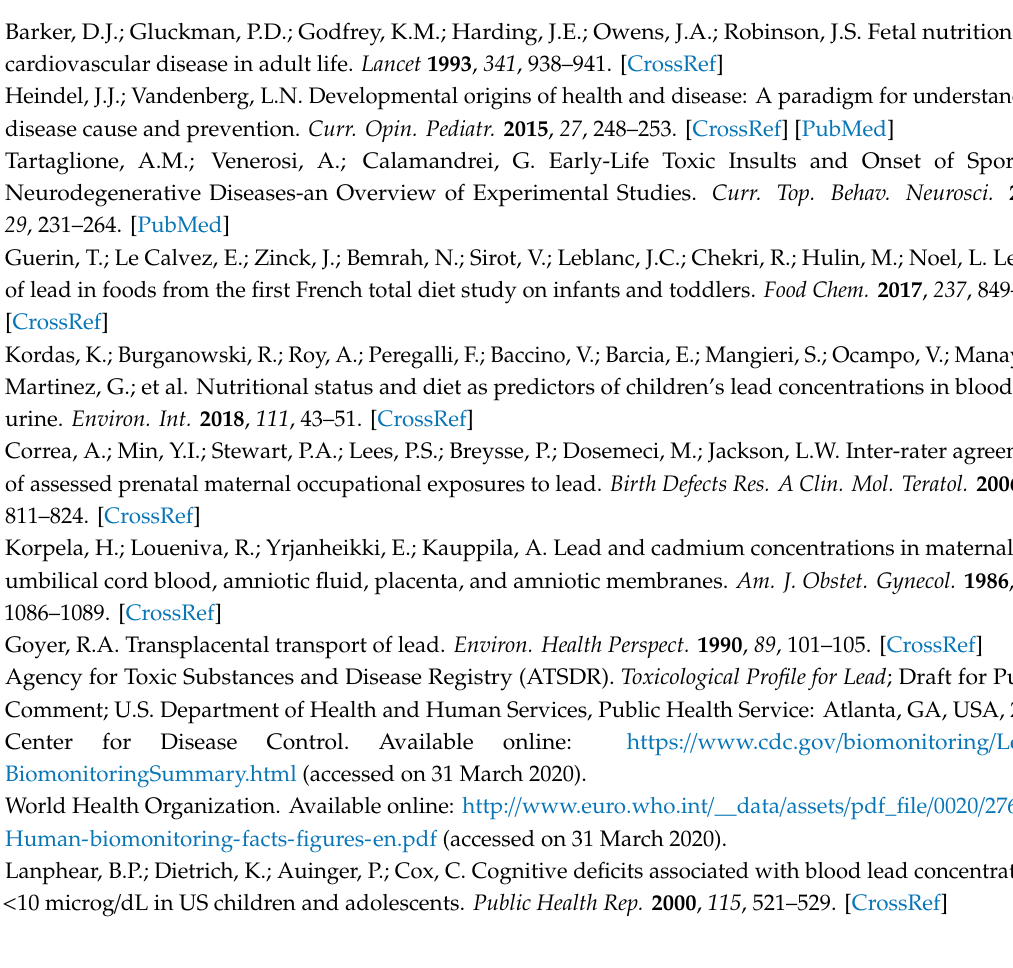
Table S2. E ff ect of Developmental Pb Exposure on the Expression of NMDA and AMPA Receptor Subunits in the Total Homogenate of 23 Post-Natal Day Female (A) and Male (B) Rat Hippocampi. Data were normalized on actin levels. Values are represented as % of Veh (mean ± SEM and n); ns—not statistically significant. Supplementary Table S3. E ff ect of Developmental Pb Exposure on the Expression of NMDA and AMPA Receptor Subunits in the Total Homogenate of 70 Post-Natal Day Female (A) and Male (B) Rat Hippocampi. Data were normalized on actin levels. Values are represented as % of Veh (mean ± SEM and n); ns—not statistically